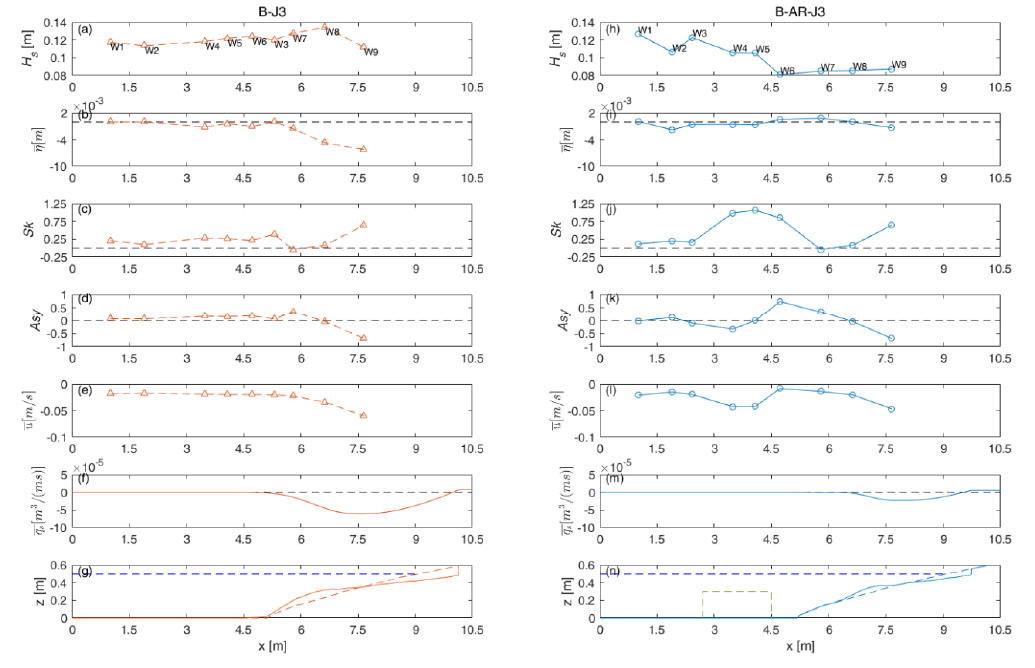
Figure 12. Cross-shore distribution of factors (same as that in Figure 11) under wave J3. The final profiles ( g , n ) are the results from the 20 min wave attack. The left panels ( a – g ) show factors in B-J3, and the right panels ( h – n ) show those in B-AR-J3, and other details are same as in Figure 11. For B-AR-R3, H reduced from the W3, and the wave heights at W6–W9 were 0.02–0.03 m smaller than in B-R3. (cid:2015)̅ was positive at all wave gauges except for W2 and W4. Two positive peaks in cross- shore distribution of Sk were located at W5 and W9, and one positive maximum of Asy was captured at W6. These indicated that main wave breaking happened on the AR, and the wave breaking on the beach started at W9. As a result, AR increased (cid:1873)(cid:3364) at W5 by 0.05 m/s and reduced at W9 by 0.01 m/s. Therefore, smaller offshore-directed total sediment transport results in a smaller sandbar (6.1 m < x < 7.6 m) compared with that in B-R3. As in Figure 12, the hydrodynamic factors in B-J3 and B-AR-J3 show similar cross-shore patterns with those in B-R3 and B-AR-R3. Since wave energy of J3 is smaller than R3, the magnitude of total sediment transport driven by J3 is smaller than in the corresponding tests under R3, and weaker breaking happens on the beach. Hence, less erosion and deposition are found in the profile (Figure 12g,n), and the topography between the scarp and sandbar shows a gentle slope instead of small bars formed in B-R3 and B-AR-R3. 4. Discussion 4.1. Implications for Beach States The concept of beach morphodynamic states [73] achieved widespread acceptance to classify the beach system on basis of complete assemblages of depositional forms and coupled hydrodynamic process signatures in the surf zone and beaches. For the micro-tidal environment, Wright and Short [73] established the relation between 3-dimensional morphology and sediment-wave parameter (Dean’s parameter H b /w s T ) to identify beach state classified as two extremes (dissipative and highly reflective states) and four intermediate states (long-shore bar-trough, rhythmic bar and beach, transverse bar and rip, and ridge-runnel or low tide terrace). In this experiment, the changes induced by AR in the beach system, despite being cross-shore process oriented, show some implications for beach state transformation on condition of uniform long-shore.